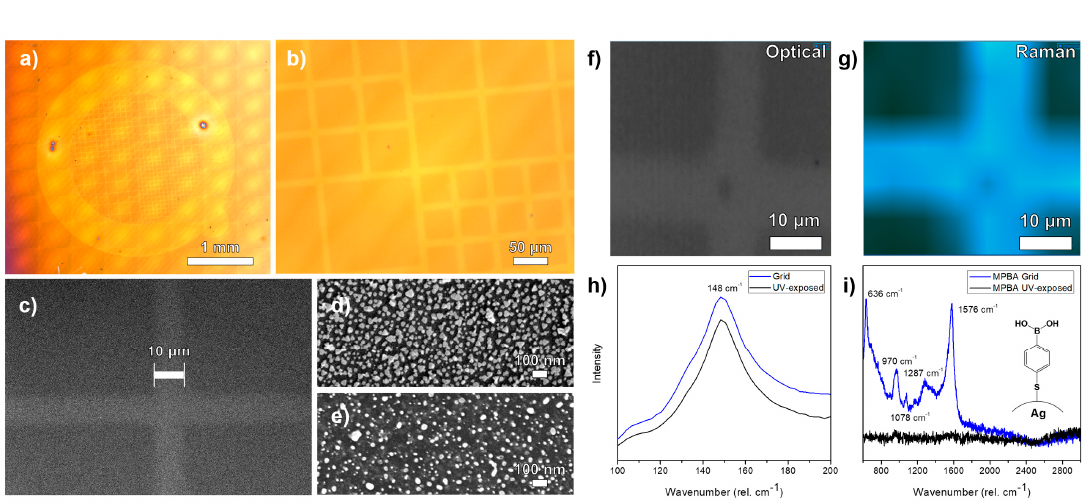
Figure 7. Photocatalytic dissolution and reshaping of triangular silver nanoprisms self-assembled on titanium dioxide upon UV irradiation ( a–c ). The prisms are transformed into spheroids ( d , e ), which results in ( f–i ) patterns having different SERS behavior. Reproduced with permission from [49], IOP